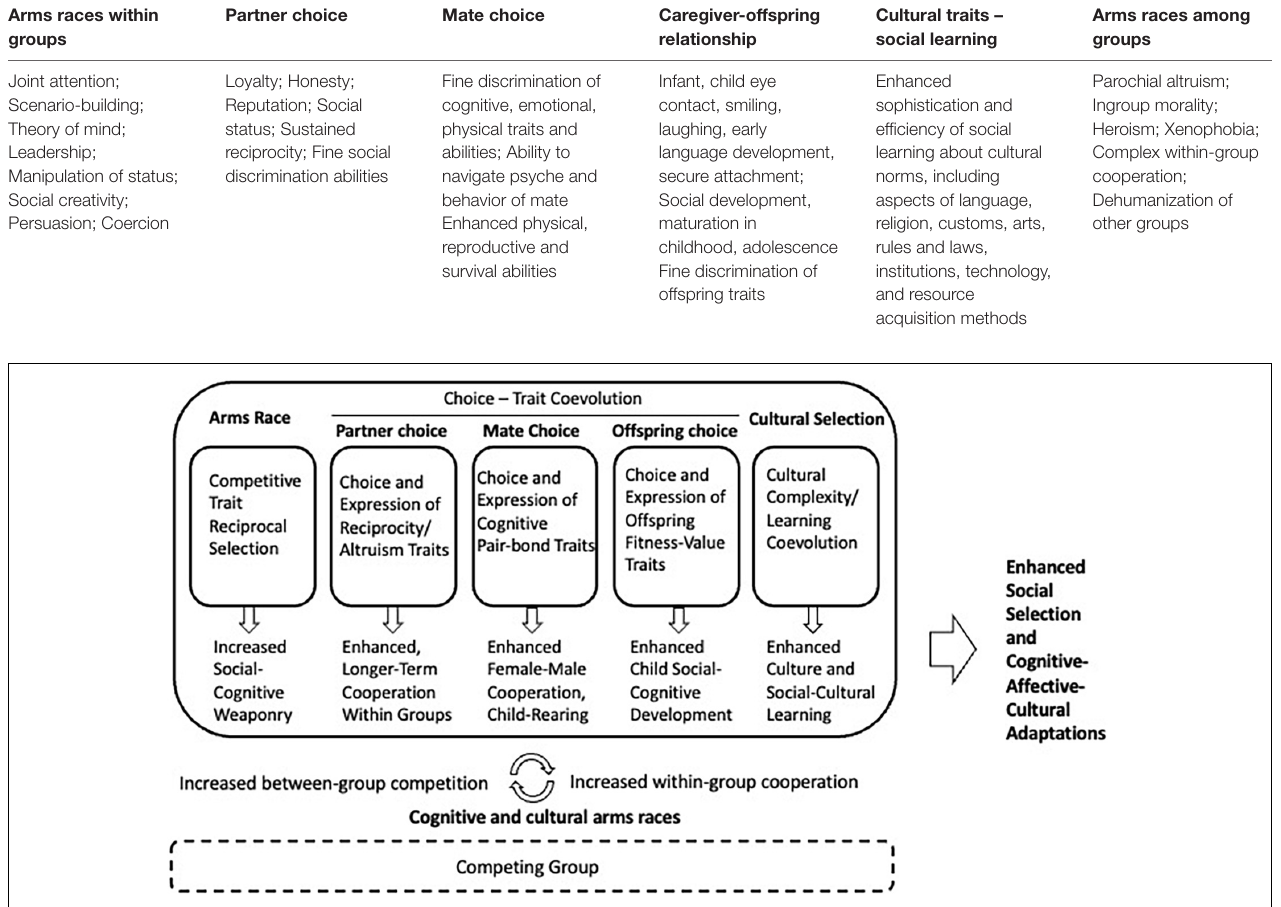
FIGURE 1 | The six arenas (five within groups, one between groups), of human runaway social selection. See Table 1 for further details on the specific phenotypes selected for in each